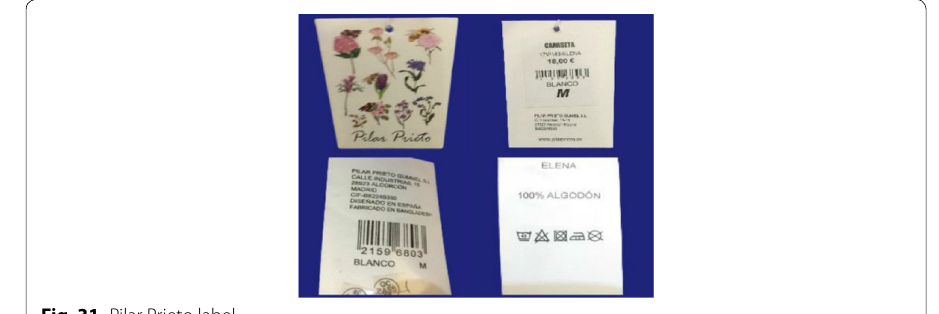
Fig. 31 Pilar Prieto label